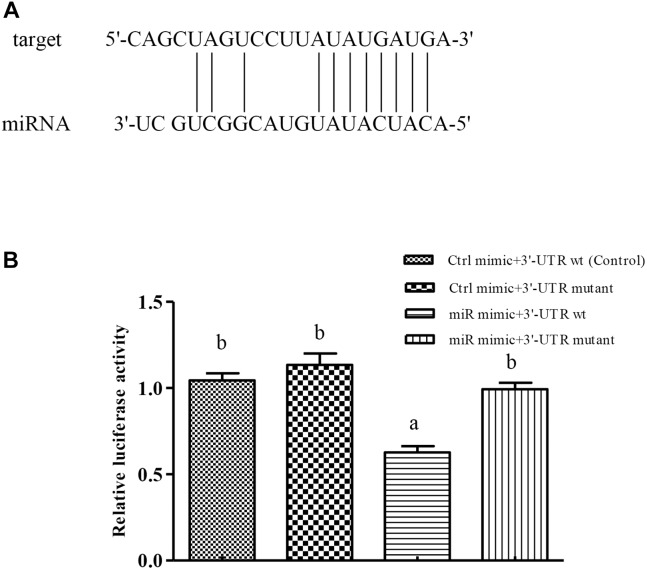
Verification of binding sites of miRNAs to potential target genes using dual luciferase reporter system. (A) miRNA can be paired with the 3′-UTR of potential target gene mRNA. (B) HEK-293T cells in 96-well plates were co-transformed with constructed pGL-Cu/Zn-SOD 3′UTR (wt) or pGL-Cu/Zn-SOD mutant (six-base mutant) and miRNA mimic or miRNA negative control (NC) (Ctrl) using Lipofectamine 2000 transfection reagent. Different lowercase letters indicate significant differences among experimental groups (P < 0.05, Duncan’s multiple comparison).